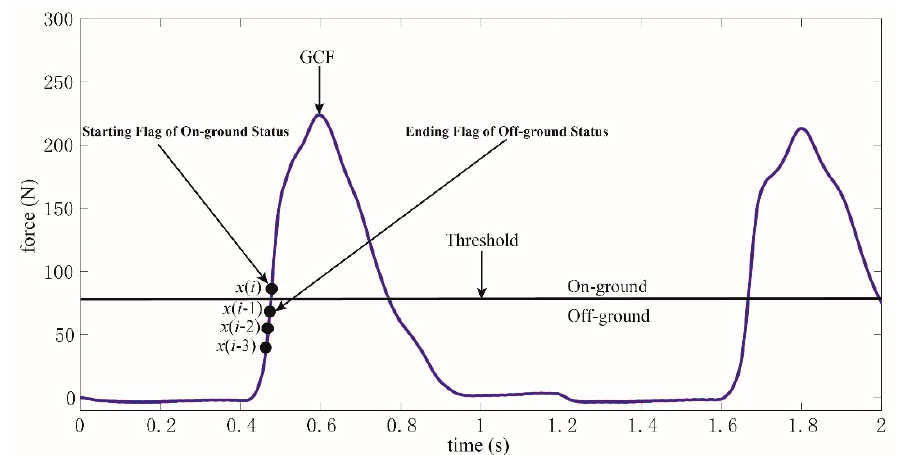
Figure 4. A curve consisting of four GCF points is used to identify the starting flag of on-ground status or the ending flag of off-ground status.